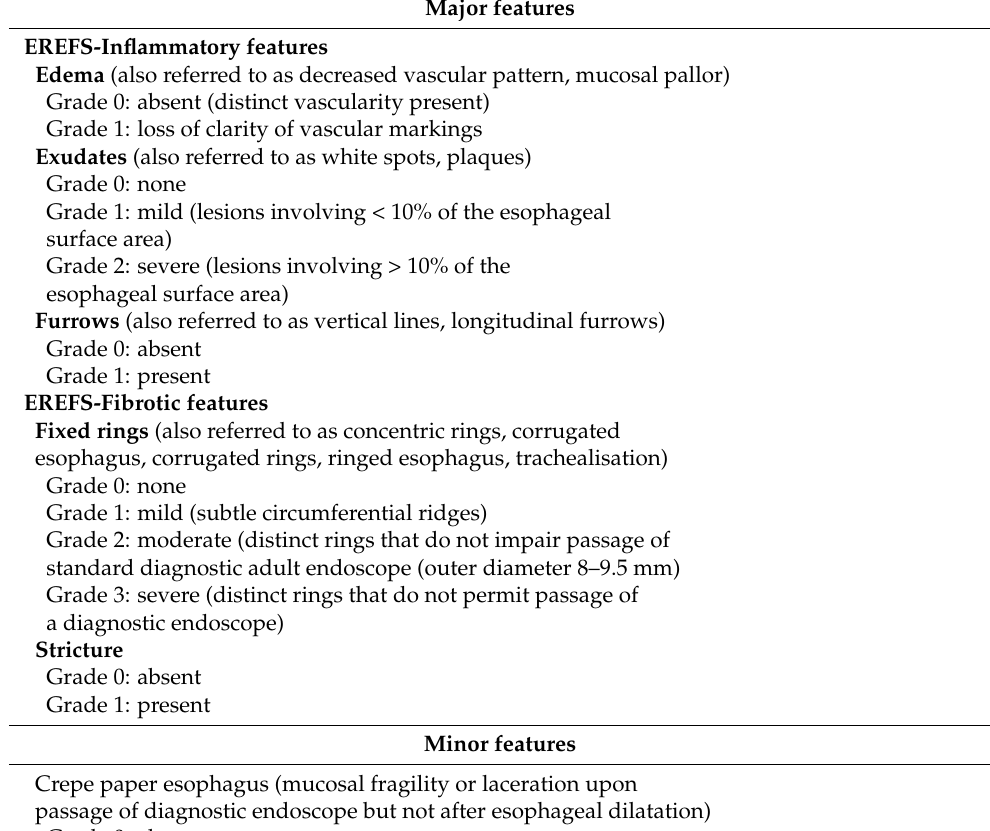
Table 2. Endoscopic reference score (EREFS) for eosinophilic esophagitis. Major